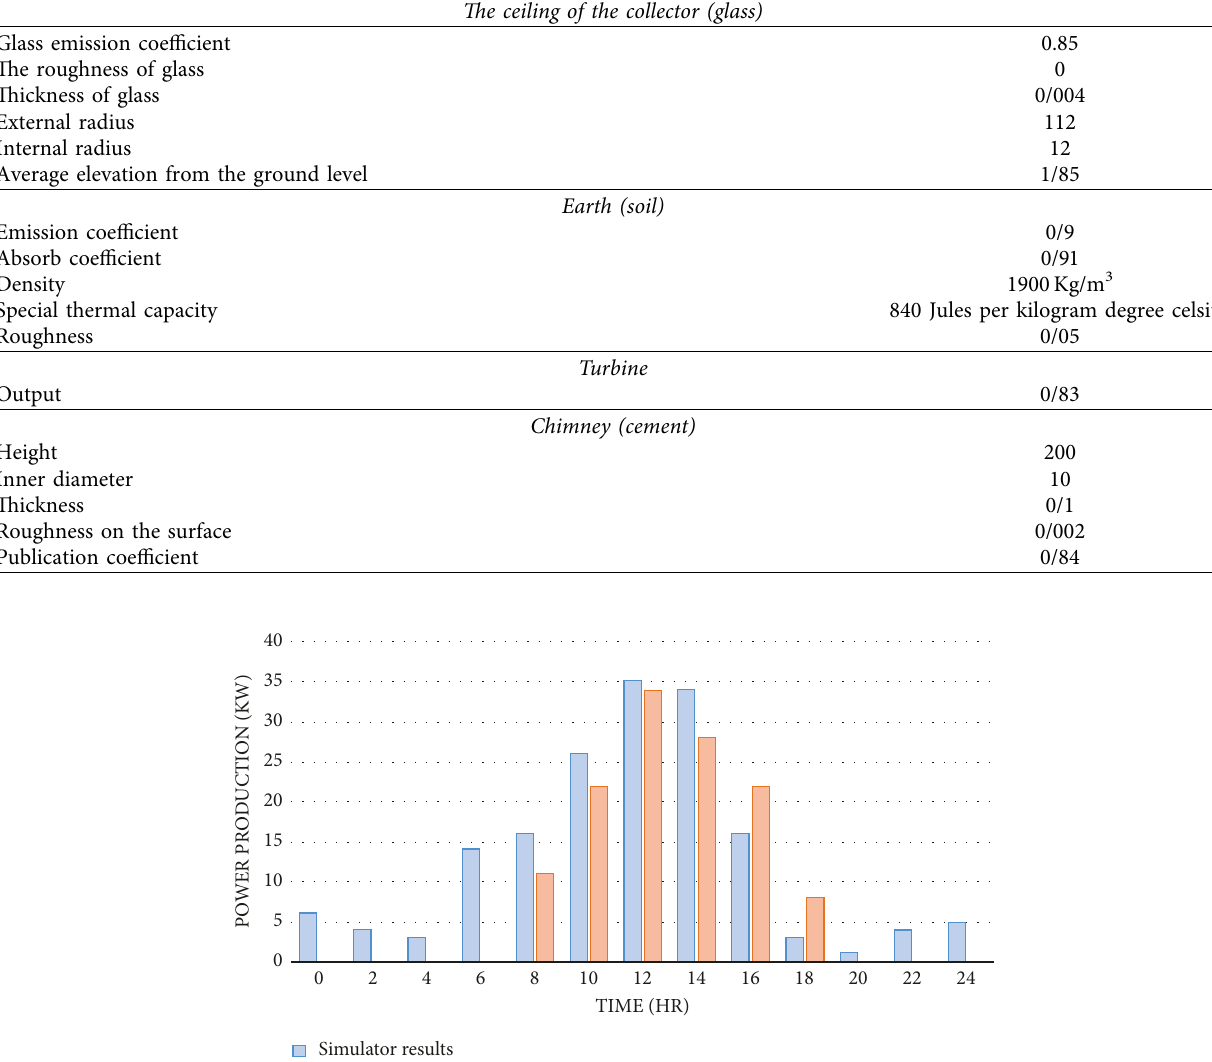
Table 1: Thermophysics properties and power plant dimensions.